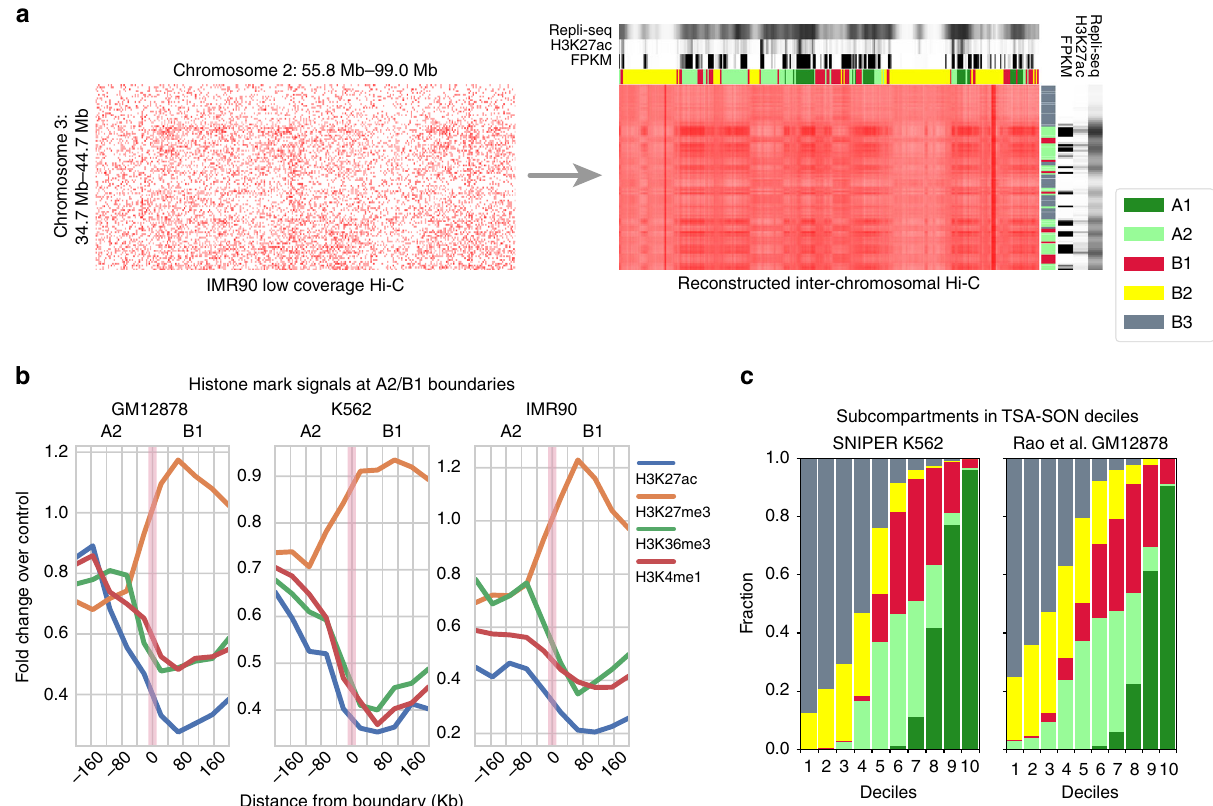
Fig. 3 SNIPER predictions correlate with various functional genomic data. a Reconstruction of the inter-chromosomal Hi-C contact matrix in IMR90. This example between chromosomes 2 and 3 shows that SNIPER imputes missing contacts in the sparse matrix, recovers subcompartment-speci fi c contact patterns, and predicts annotations that correlate with DNA replication timing Repli-seq, H3K27ac ChIP-seq, and RNA-seq (FPKM). b Normalized histone mark signal changes at the boundary between A2 (left) and B1 (right) in GM12878, IMR90, and K562. c Subcompartment distribution in K562 SON TSA- seq deciles for the SNIPER K562 subcompartments (left) and the Rao et al. 5 GM12878 subcompartments (right). Source data are available in the